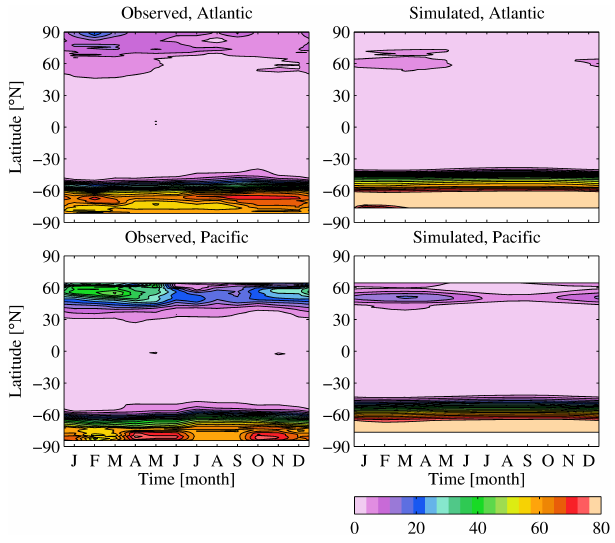
Fig. 6. Hovm¨oller diagrams of observational (World Ocean Atlas, 2009; left) and simulated (right) monthly surface dissolved inorganic nitrogen, averaged zonally for the Atlantic (top) and Pacific (bottom) basins. Concentrations in mmolNm − 3 .